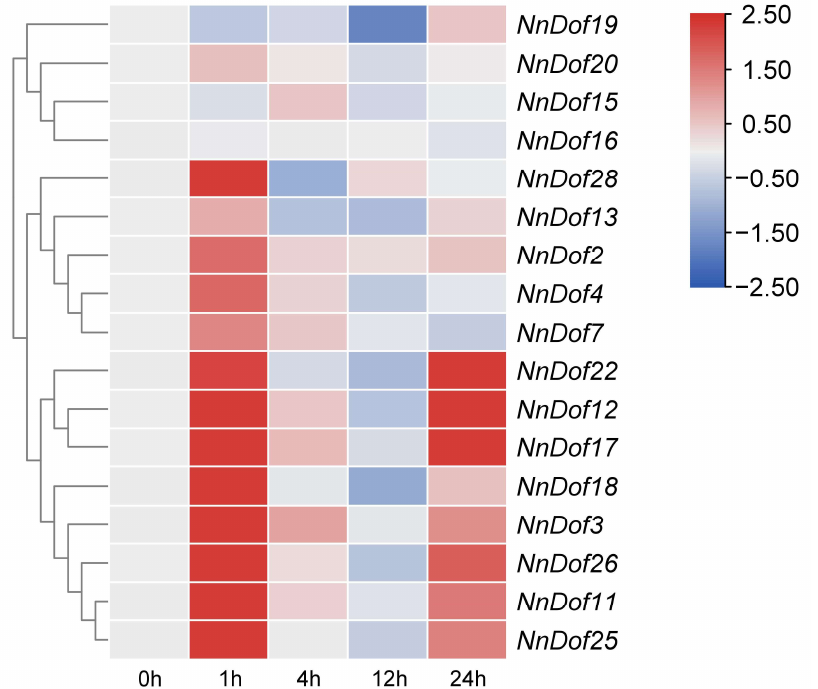
Figure 9. Expression profiles of NnDofs genes responding to salt stress. Blue indicates decreased expression levels and red indicates increased expression levels. Heatmaps were generated with TBtools